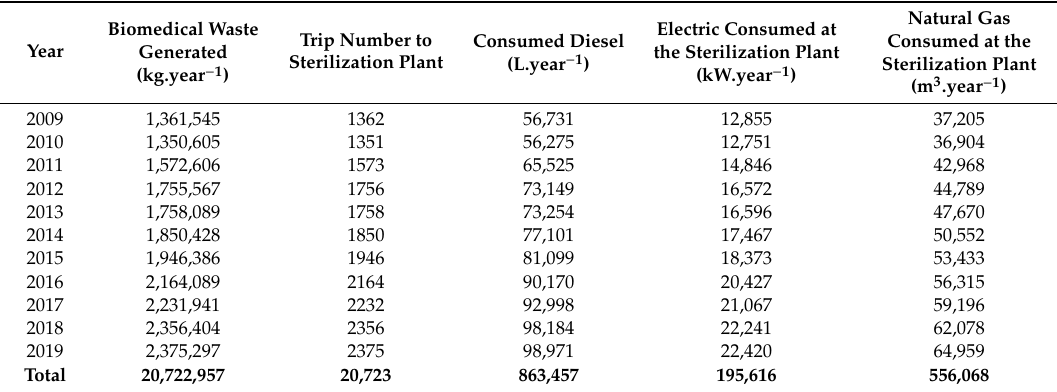
Table 2. Amounts of biomedical waste collected and treated from 2009 to 2019 and the associated fuel